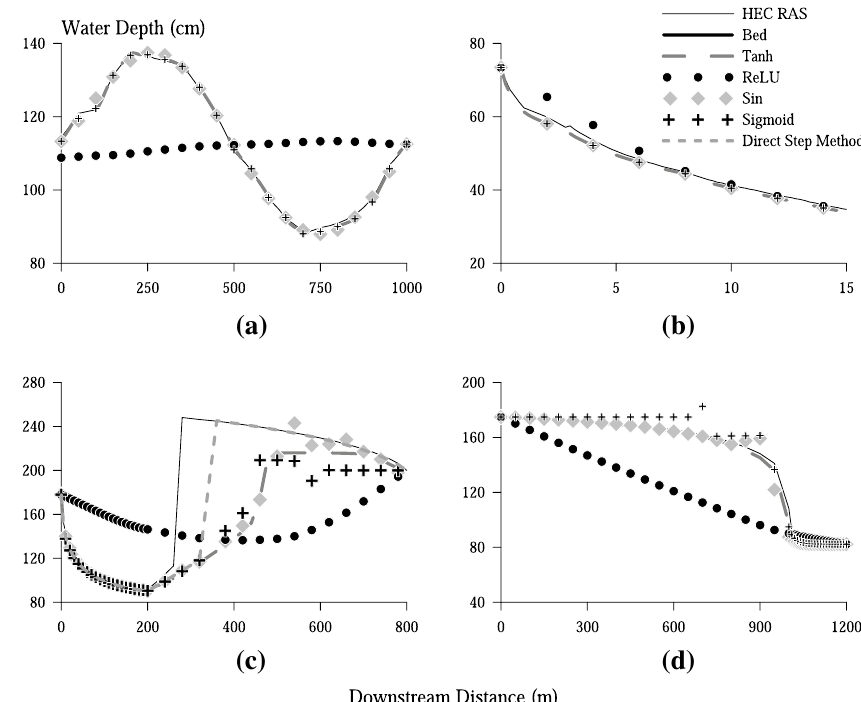
Fig. 6 PINN results with the best case for each activation function for: a Case 1, b Case 2, c Case3, and d Case 4